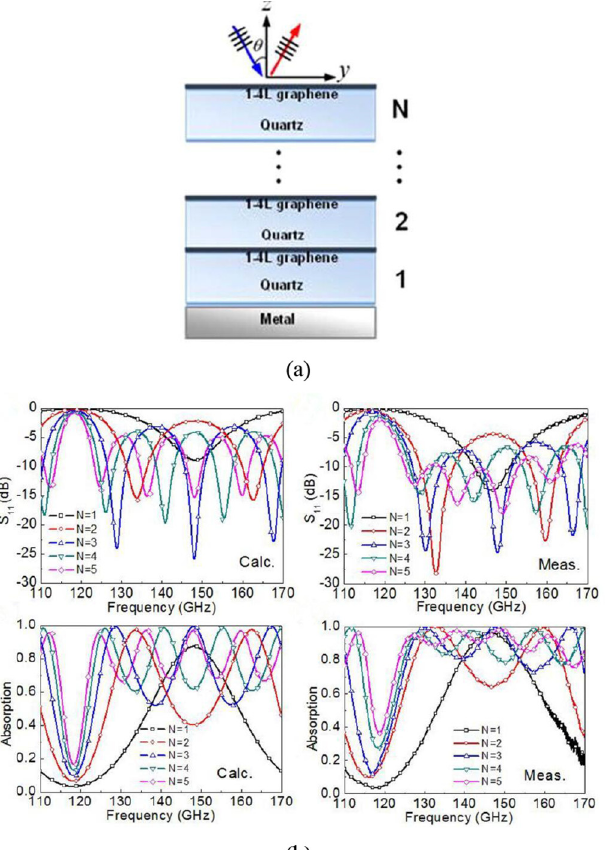
Fig. 3. (a) The con fi guration of the broadband absorber. (b) Comparison of calculated and measured | S 11 | and absorption of stacked graphene – quartz absorbers.